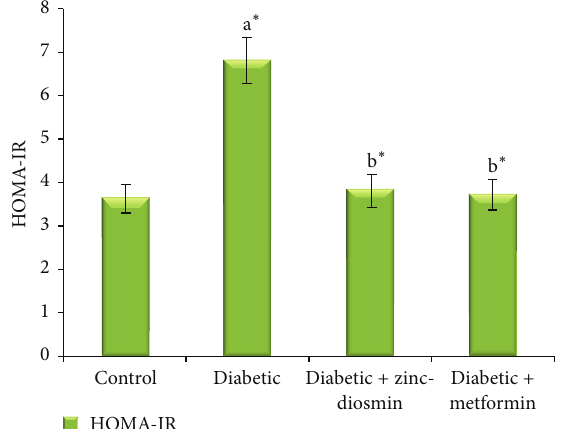
Figure 8: Effect of zinc-diosmin complex on insulin sensitivity in experimental groups of rats. Results are expressed as mean ± SEM [ 𝑛 = 6 ]. One-way ANOVA followed by post hoc test LSD was done. The results were compared with a Control rats and b Diabetic rats. Values are statistically significant at 𝑃 < 0.05 .